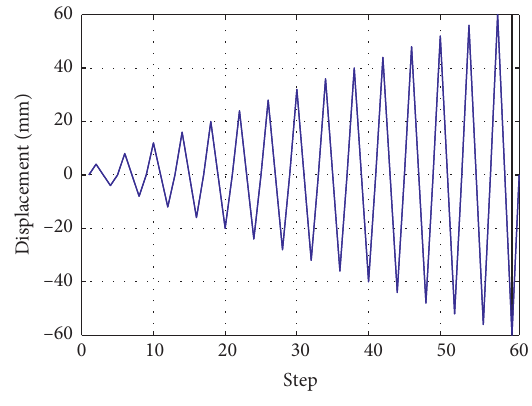
Figure 5: Loading system.